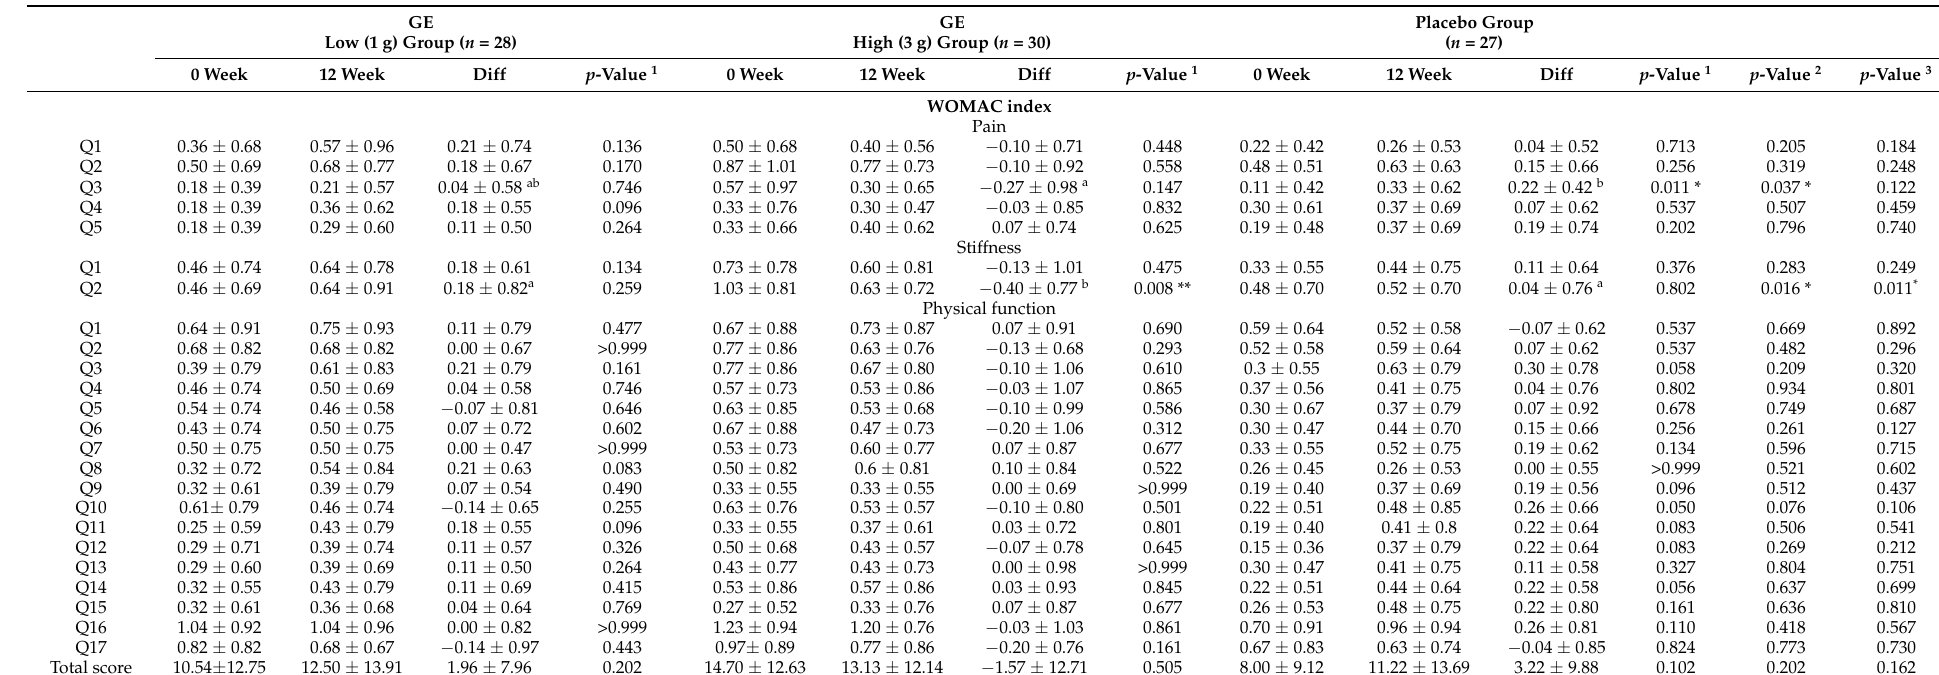
Table 5. Changes in WOMAC scores in subjects during the intervention